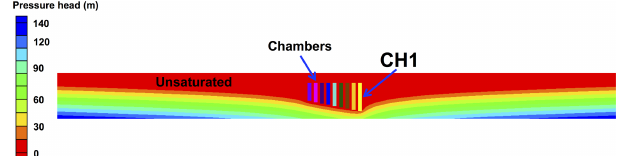
Figure 3. Computed pressure head distribution used as initial con- dition for the transient state